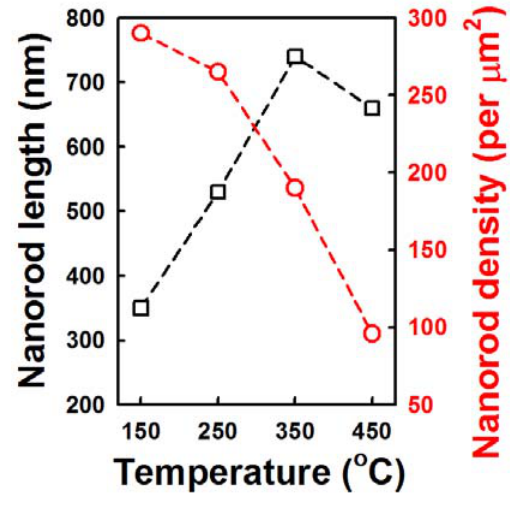
Figure 5. The average length (rectangular) and density (circle) of ZnO NRs with various seed layer annealing